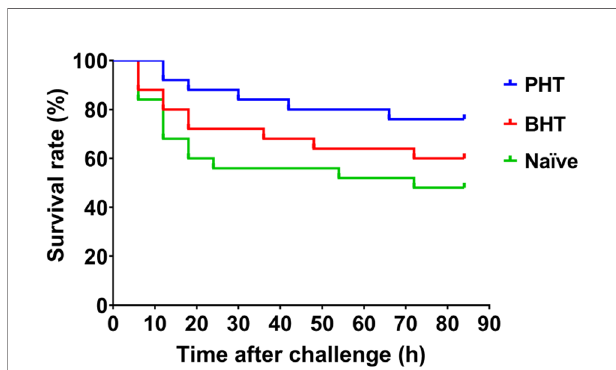
FIGURE 2 | The survival rate of recipient crabs after the transfer of primed haemolymph improved. Compared with naïve crabs (Naive) or blank haemolymph transferred (BHT) crabs, the survival rate of Primed haemolymph (PHT) recipient crabs was increased after A.